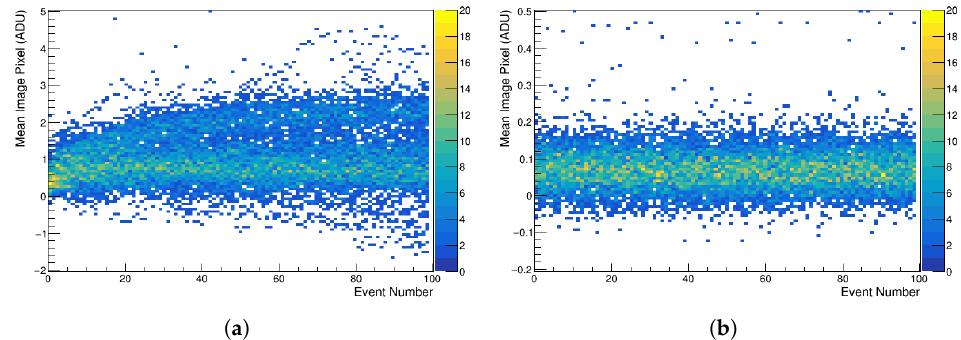
Figure 12. Mean ADU value of exposure frames versus event number for 150 runs (of 100 events, i.e., frames) taken over a number of days ( a ) before row correction (demonstrating pixel pedestal drift) ( b ) after row correction. The latter demonstrates the correction of the pedestal drift by the row correction